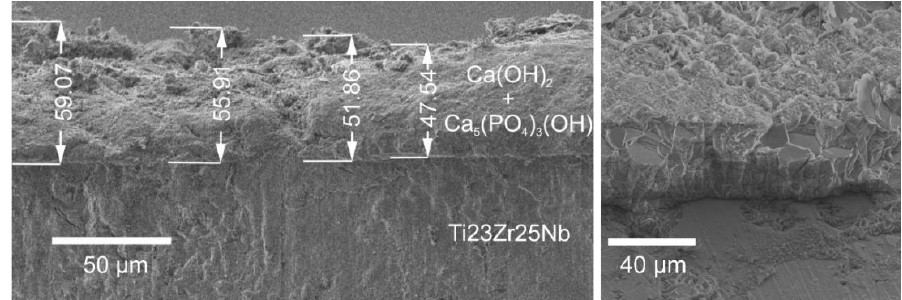
Figure 4. Tilted-views of Ti23Zr25Nb modified in 0.042M Ca(NO 3 ) 2 + 0.025M (NH 4 ) 2 HPO 4 + 0.1 M HCl bath with the voltage of −10 V vs. OCP and the time of 60 min (B1) at 90 (on the left) and 51 (on the right) tilt angle.